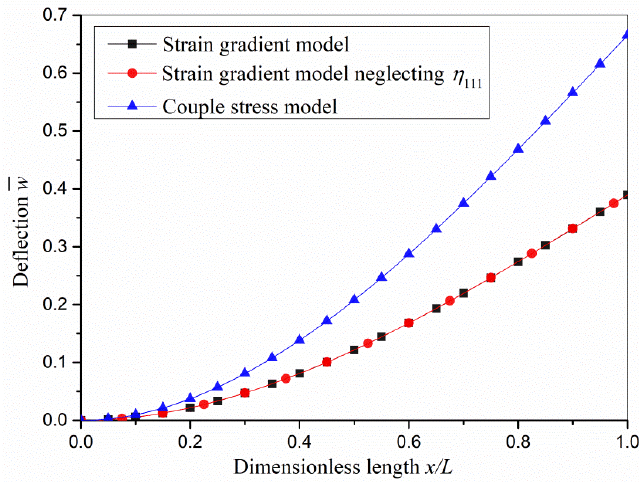
Figure 5. The deflection of cantilever